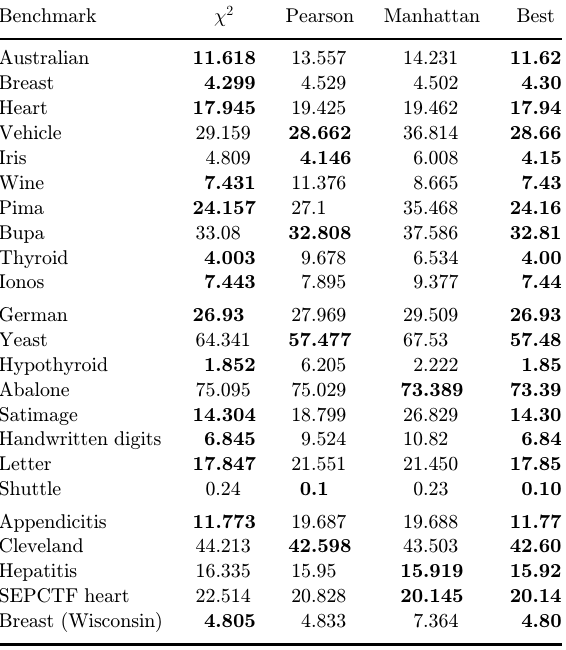
Table 6. Error rate for ULR-Discr using, respectively, the (cid:1) 2 , the Pearson coe±cient and the distance of Manhattan.